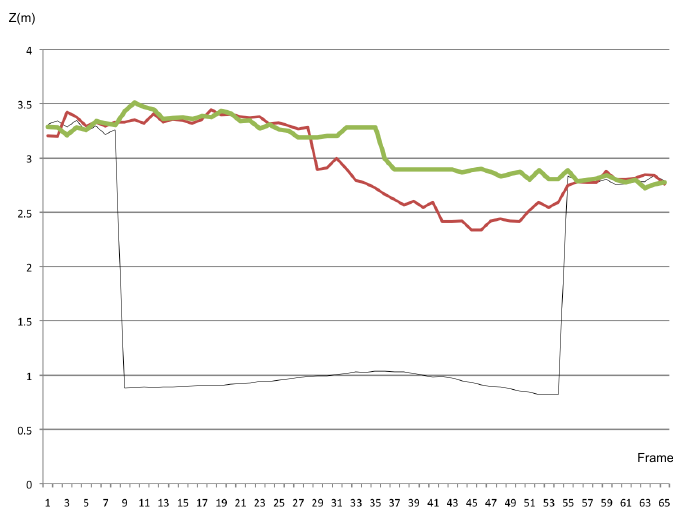
Figure 36. Outlier zone: this graph is a detail of the graph of the Figure 32, from the frame 44 to frame 108, here we can compare the estimation in the outlier zone with and without the use of the filter and adding the color constraints to the filter. The black curve is the estimation without filter, the red curve is the estimation with filter and the green curve is the estimation using the filter with color constraints of the target. The frame 44 was renumbered with the number